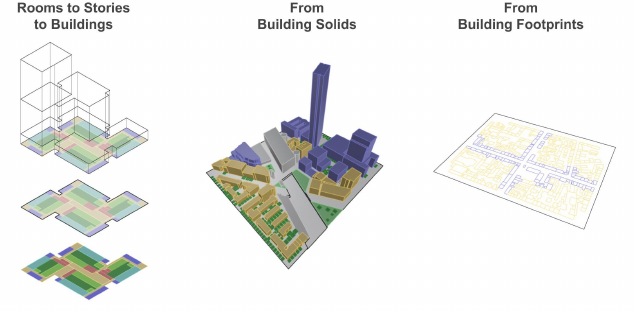
Figure 1. Urban geometry workflows currently supported by the Dragonfly